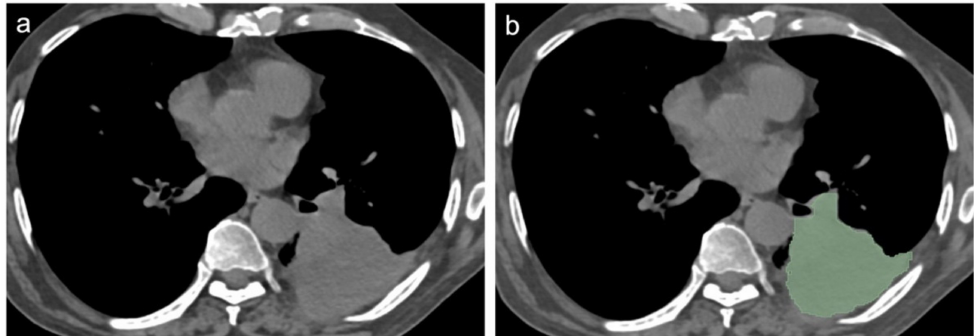
Figure 3. ( a ) Lung window and ( b ) mediastinal window of axial thin-section unenhanced chest CT images of a 21-year-old man. Images show a single consolidation opacity with air bronchogram and irregular margins in the right upper lobe, associated with one gross cavitation (asterisks). Diagnosis of pulmonary tuberculosis was confirmed by pulmonary biopsy.